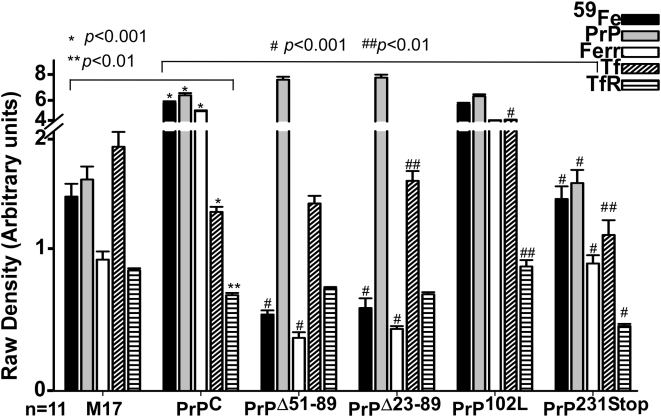
Quantitative analysis of the results in Figures 1–
3.Quantitative evaluation after densitometry of ferritin iron and levels of PrP, ferritin, Tf, and TfR in PrPC, PrPΔ51–89, PrPΔ23–89, PrP102L, PrP231stop-cells relative to non-transfected M17 controls. Values are mean±SEM of 11 independent experiments. The y-scale is linear but has been re-scaled after the break to illustrate the data clearly. For M17 vs. PrPC *p<0.001, **p<0.01, and for PrPC
vs. mutant cell lines #
p<0.001, ##
p<0.01).